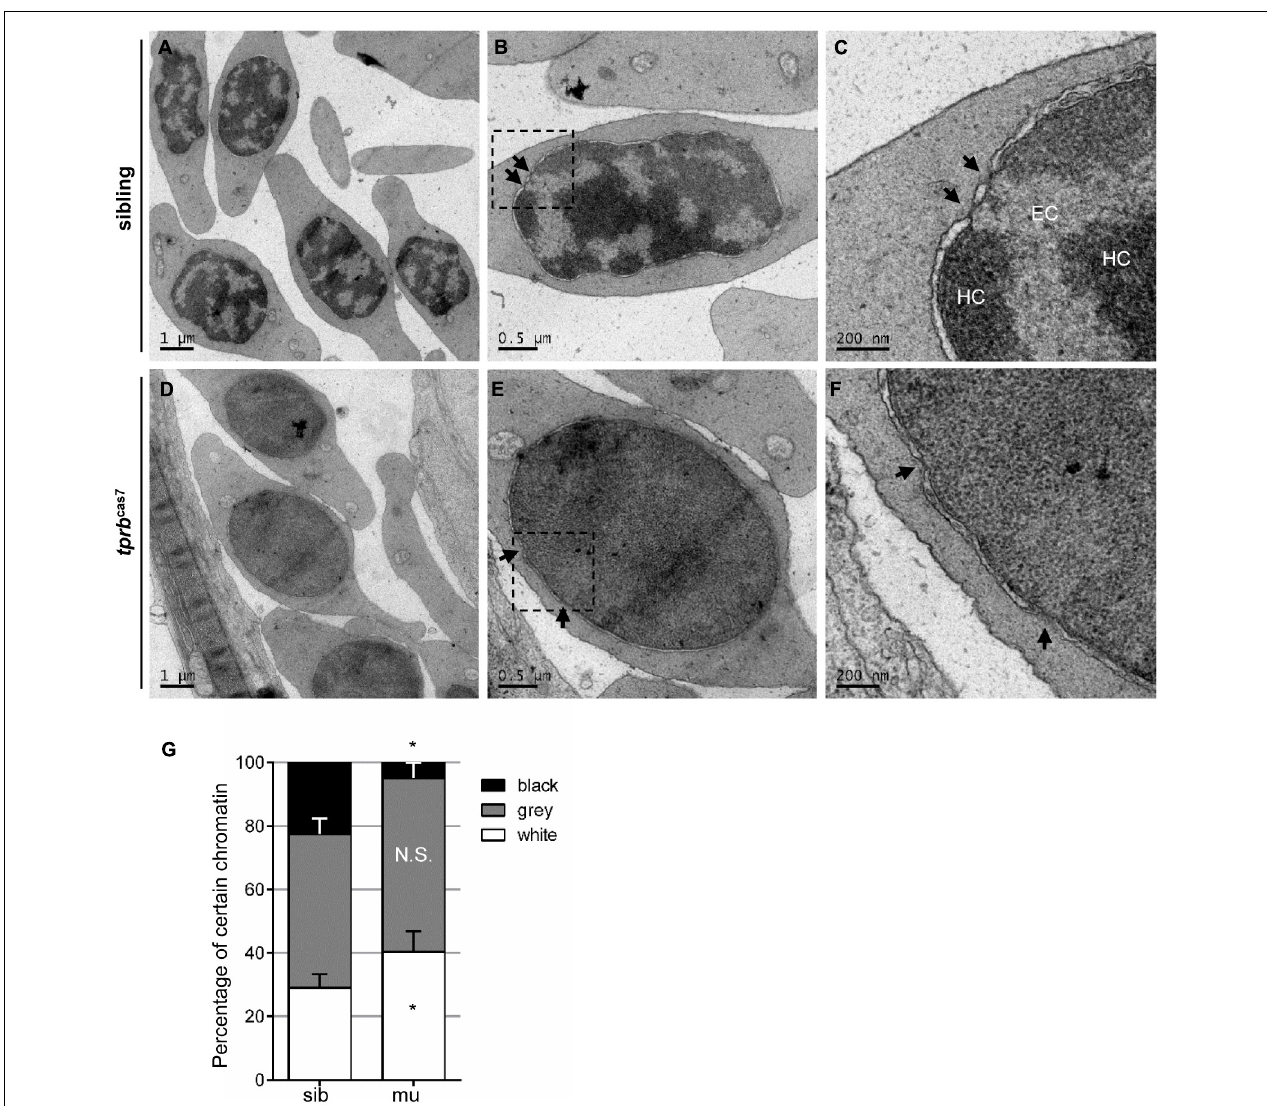
FIGURE 6 | Chromatin condensation is defective in tprb cas 7 mutant erythroid cells. (A–F) Representative transmission electron microscopy (TEM) images of erythrocytes from sibling (A–C) and tprb cas 7 mutants (D–F) at 4 dpf. The images in panels (C,F) showed a higher magnification of the corresponding boxes (B,E) . Arrows indicate nuclear pores. EC, euchromatin; HC, heterochromatin. Scale bars are shown in each image. (G) Quantifications of certain chromatin with classified different color in sibling and tprb cas 7 mutants at 4 dpf. Error bars represent SEM. N.S., not significant; * p <